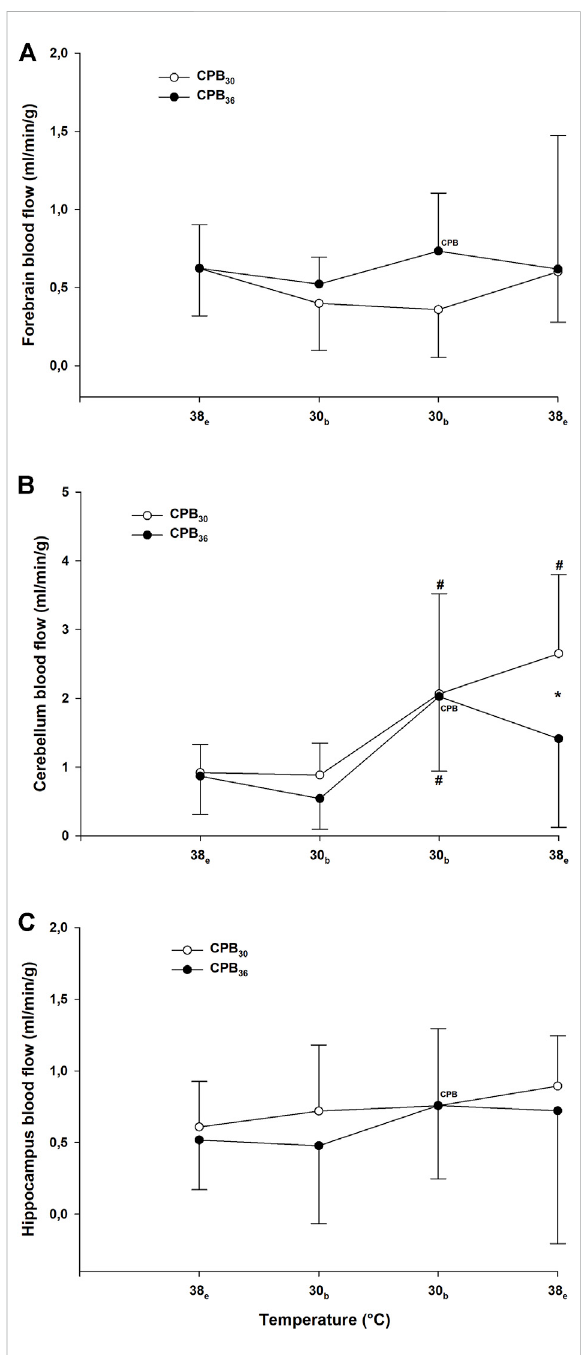
FIGURE 5 Cerebral blood fl ow. (A) : forebrain; (B) : cerebellum; (C) : hippocampus. Temperature measured in: e – esophagus; b – bladder. Data presented as mean and SD. # p < 0.05 vs. intragroup baseline; * p < 0.05 vs corresponding value in another group; CPB – variables measured during ongoing